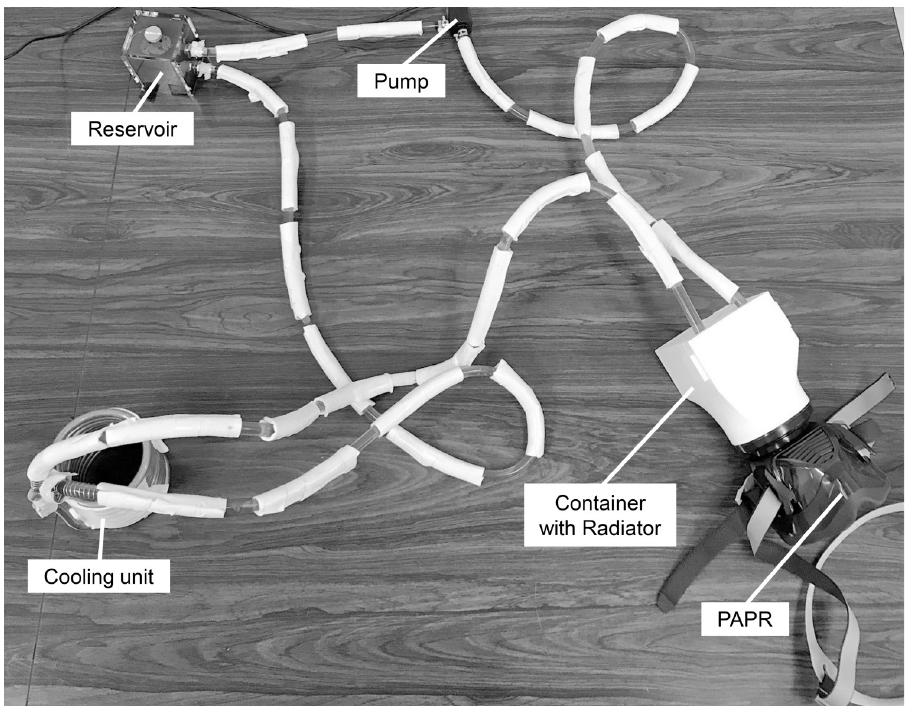
Fig 2. Photograph of the cooling device. PAPR: powered air-purifying